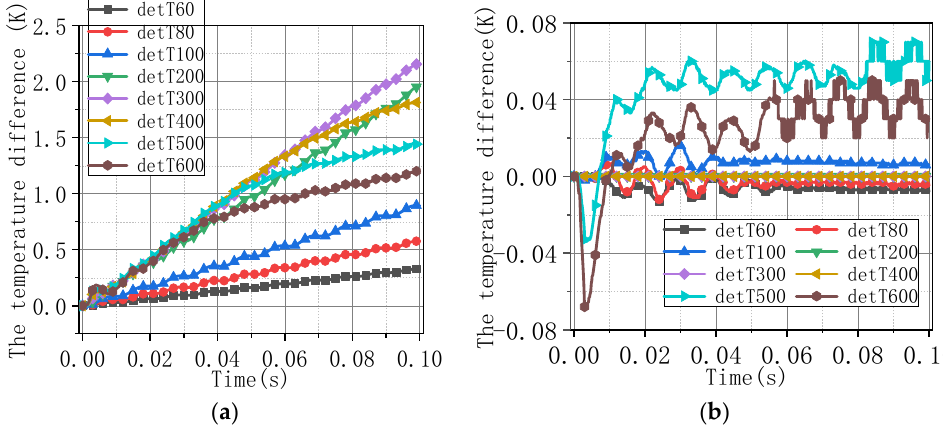
Figure 13. The highest temperature difference under different current amplitudes: ( a ) under Model A and B; ( b ) the 16-turn coil–the 50-turn